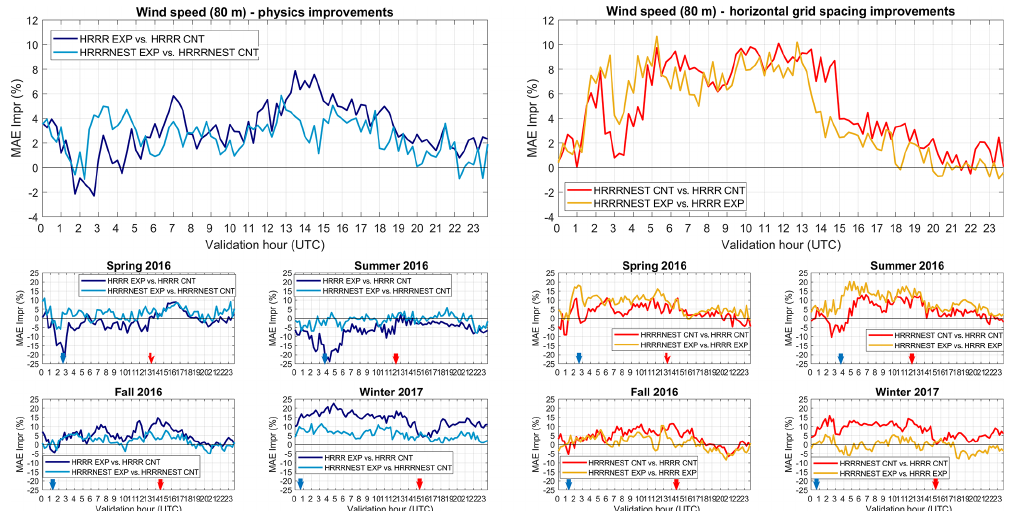
Figure 7. Improvements in 80m wind speed MAE due to the experimental physics (left panels) and finer horizontal grid spacing (right panels) for the four reforecast periods averaged together (upper panels) and for the four reforecast period separately (lower smaller panels) for all reforecast runs. Dark blue is HRRR EXP vs. HRRR CNT, light blue is HRRRNEST EXP vs. HRRRNEST CNT, red is HRRRNEST CNT vs. HRRR CNT, and orange is HRRRNEST EXP vs. HRRR EXP. Red and blue arrows on the y axes represent the sunrise and sunset times, respectively.